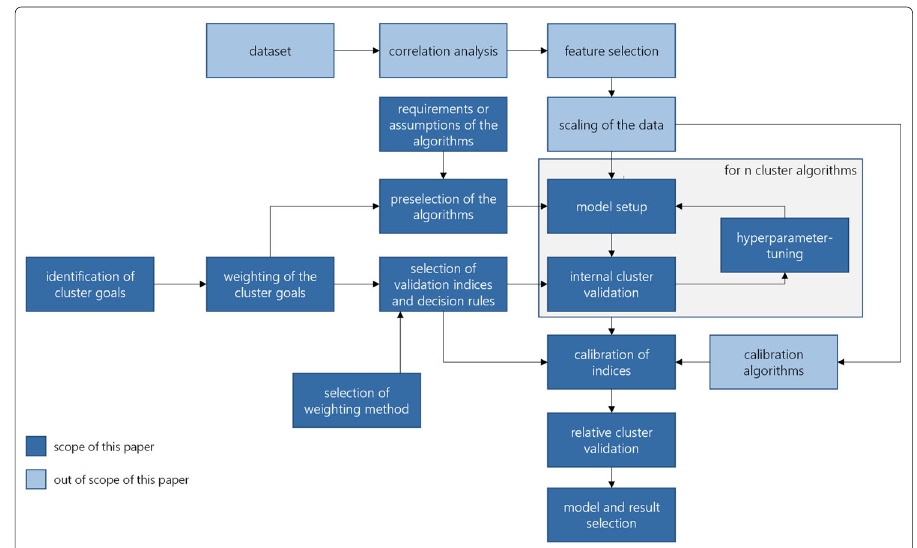
Fig. 1 Methodology of cluster